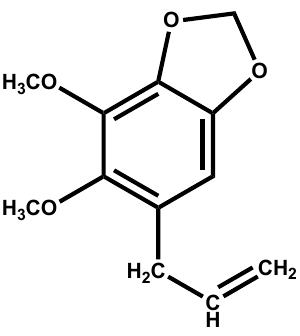
Figure 1. The structure of dillapiole.